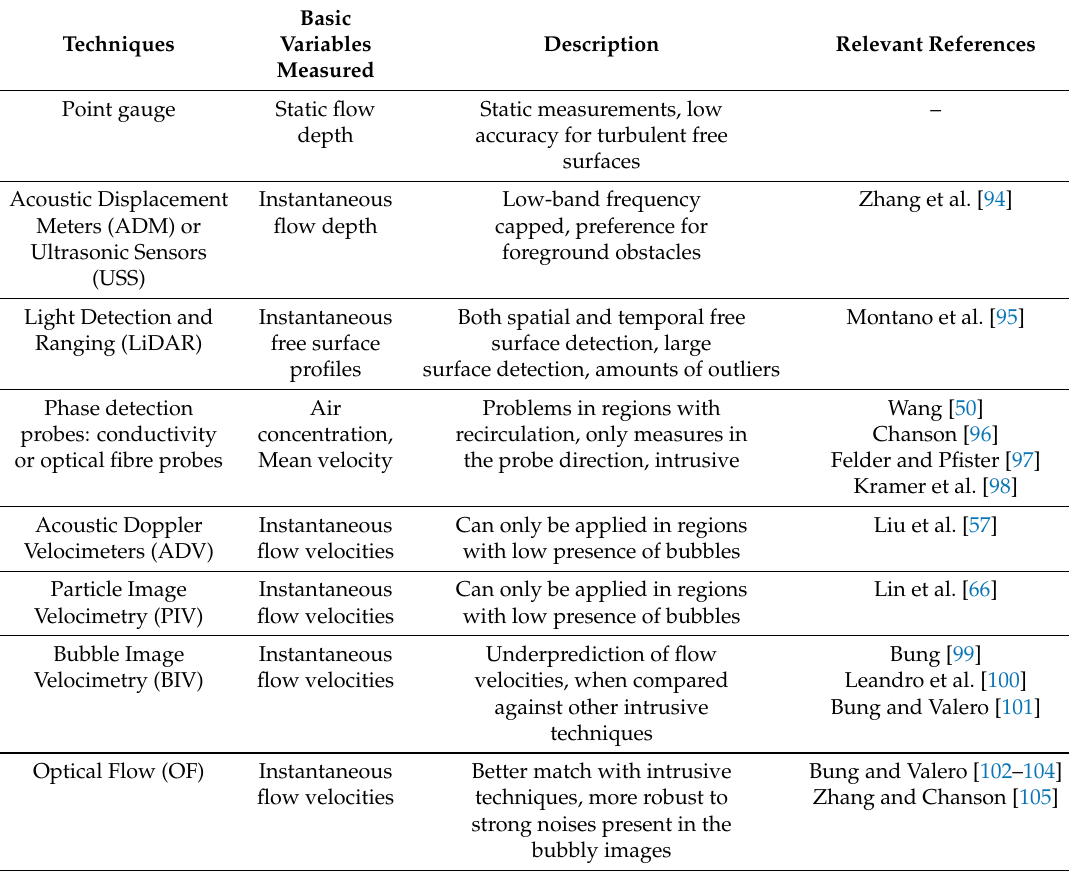
Table 3. Instrumentation and